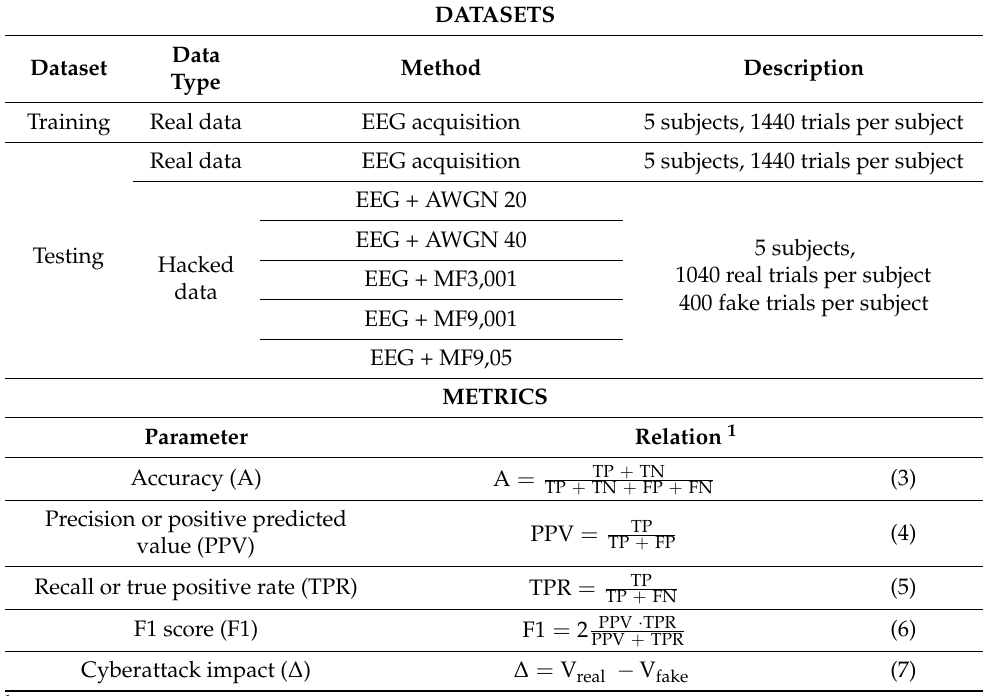
Table 2. Datasets used in this study and metrics of